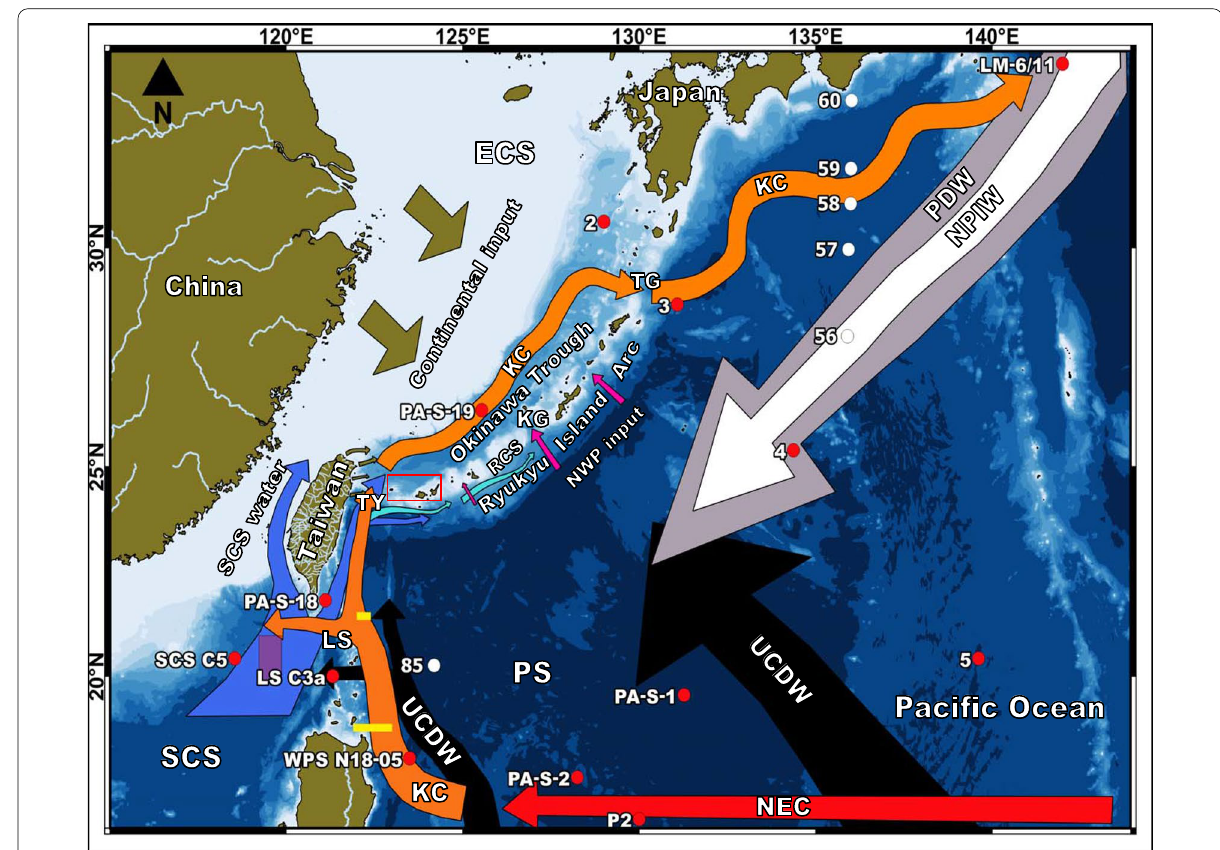
Fig. 1 Surface and subsurface current systems in the northwestern Pacific Ocean. Red points represent stations from which Nd isotope data have been reported in previous studies: LM-6/11 (Amakawa et al. 2004b); PA-S-1, PA-S-18, and PA-S-19 (Amakawa et al. 2000); 2, 3, 4, and 5 (Behrens et al. 2018); LS C3a, P2, SCS C5, and WPS N18-05 (Wu 2014). Abbreviations: ECS, East China Sea; KC, Kuroshio Current; KG, Kerama Gap; LS, Luzon Strait; NEC, North Equatorial Current; NPIW, North Pacific Intermediate Water; PDW, Pacific Deep Water; PS, Philippine Sea; RCS, Ryukyu Current System; SCS, South China Sea; TY, Strait between Taiwan and Yonaguni Jima Island; TG, Tokara Gap; UCDW, Upper Circumpolar Deep Water. White points represent stations for which δD values were reported by Horibe and Ogura (1968) (Additional file 5: Fig. S3). The horizontal yellow line in the Luzon Strait indicates a transect studied by Mensah et al.